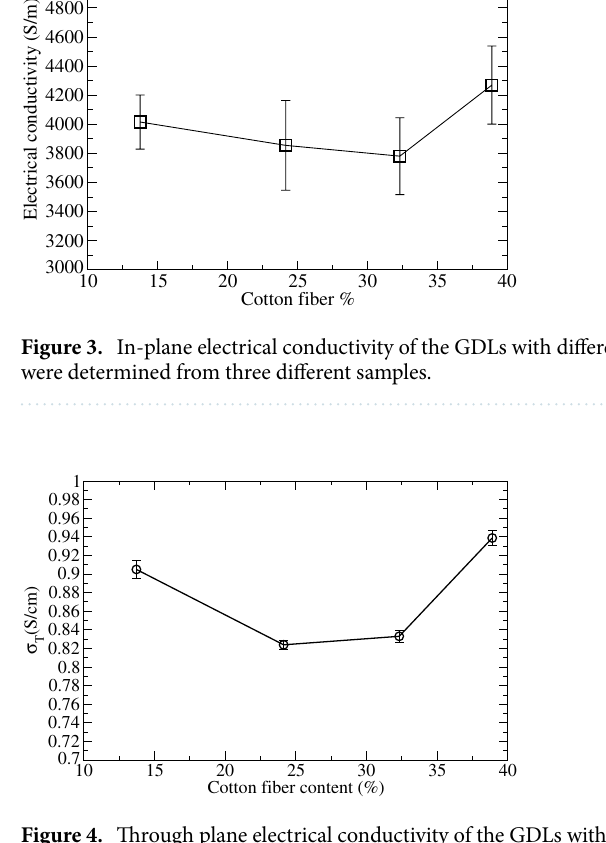
Figure 4. Through plane electrical conductivity of the GDLs with different percentages of cotton content. Error bars were determined from three different samples.